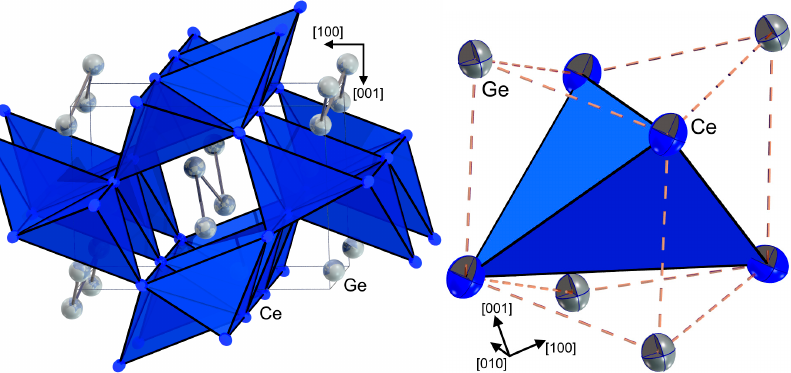
Figure 4. Crystal structure of CeGe depicted as ( left ) network of corner-sharing Ce 4 tetrahedra and ( right ) stella quadrangula formed around each Ce 4 tetrahedron.